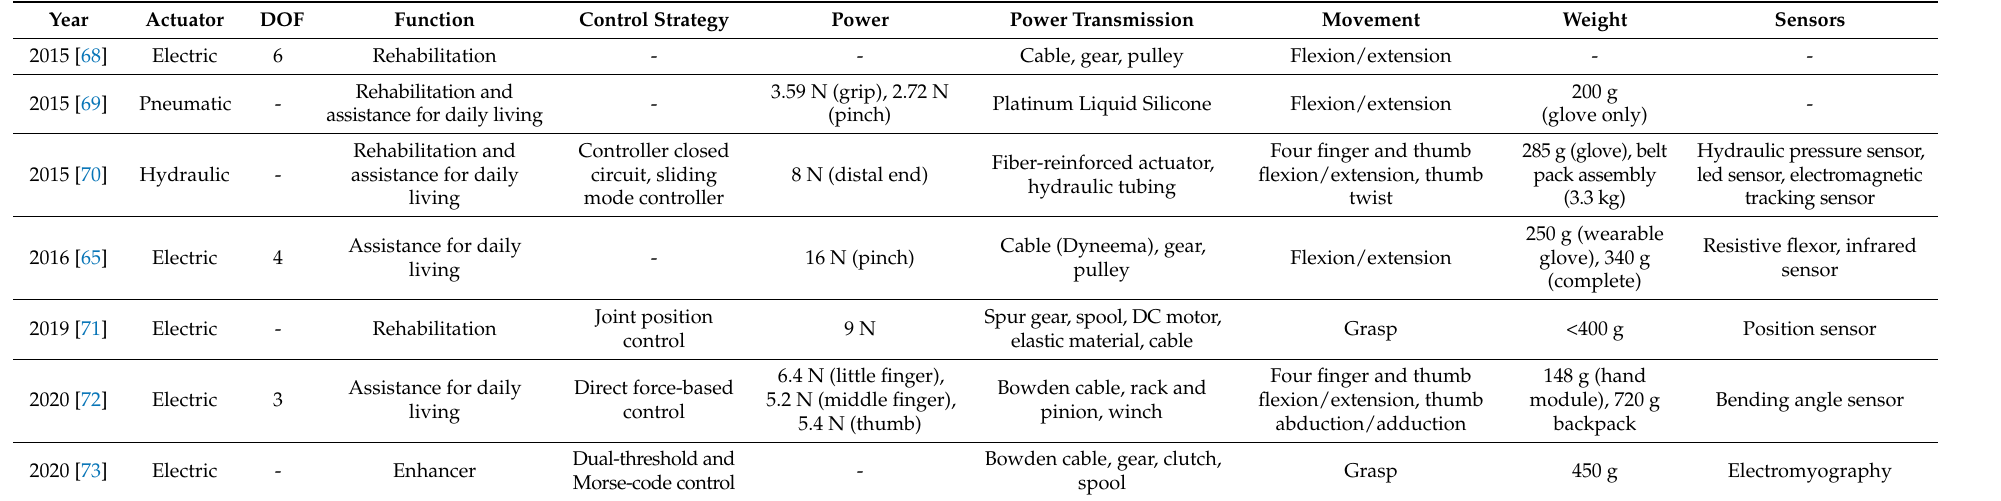
Table 4. Development of soft exoskeletons for the